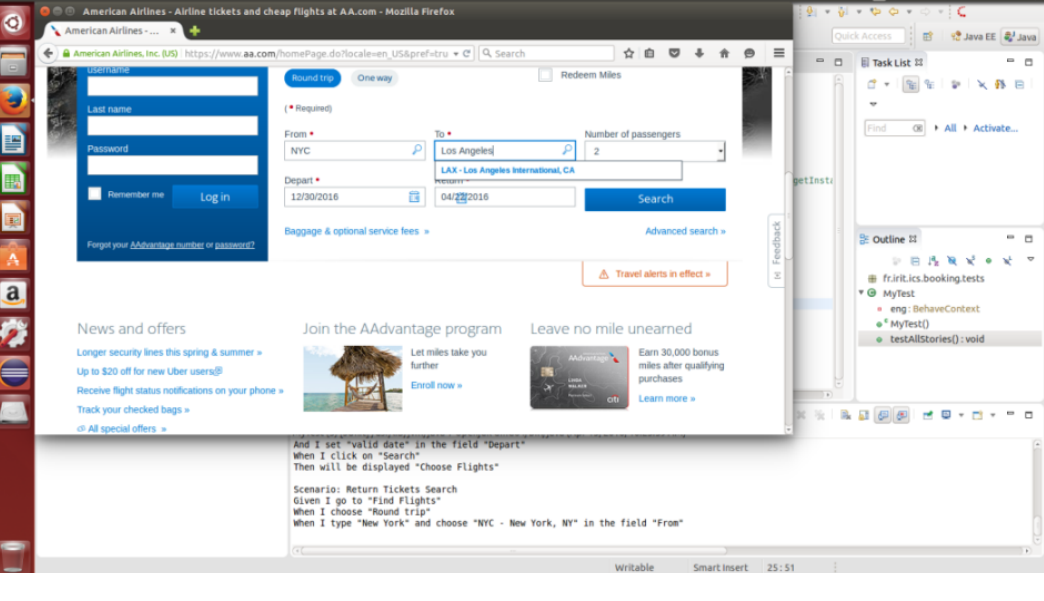
Figure 28. Automated execution of the Scenario “Return Tickets Search” dataProvider.put("valid date", "12/30/2016");